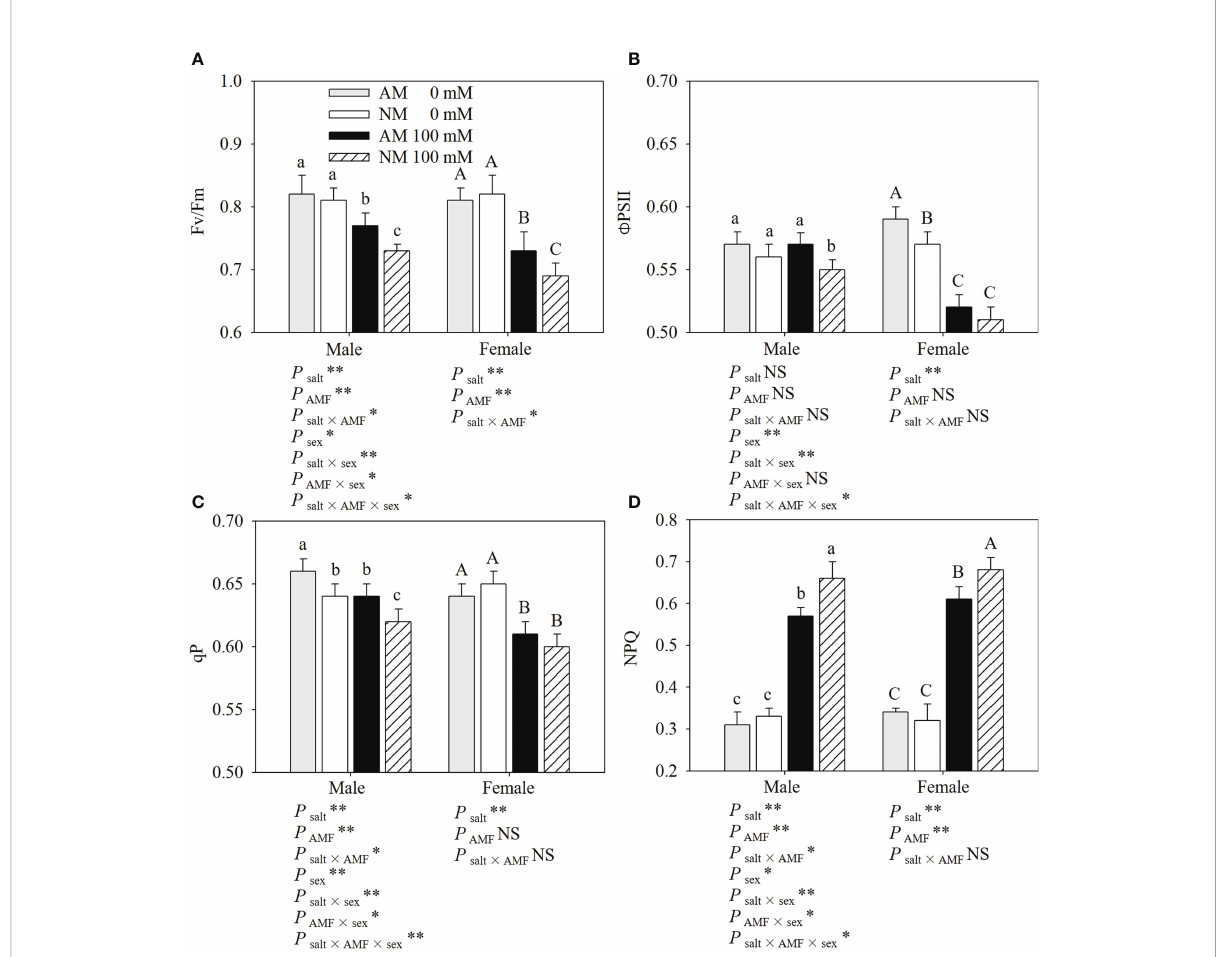
FIGURE 2 Effects of AMF inoculation on Fv/Fm (A) , F PSII (B) , qP (C) and NPQ (D) of P. euphratica males and females under different salt conditions AM, AMF inoculation; NM, non-inoculation; 0 mM, without salt stress; 100 mM, under salt stress; AMF, AMF formation; **: signi fi cant effect at P ≤ 0.01; *: signi fi cant effect at 0.01 < P ≤ 0.05; NS: no signi fi cant effect. Different letters (lowercases for males and capital letters for females) indicate signi fi cant difference at P ≤ 0.05, the data are means ± SD (n =